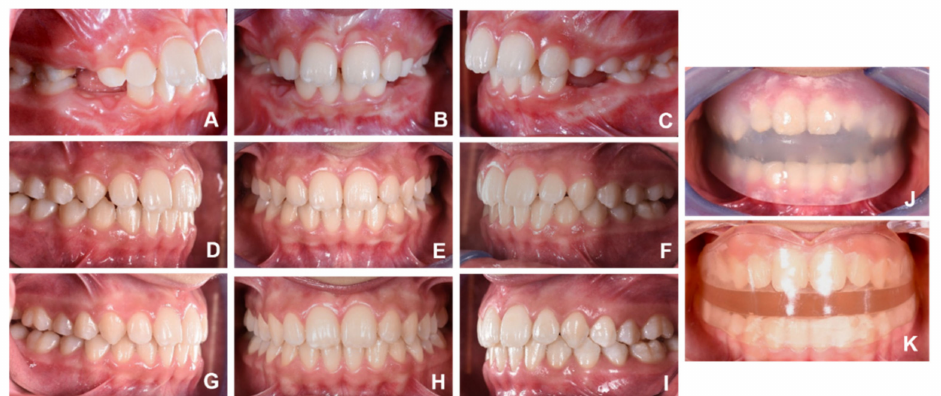
Figure 6. ( A – K )—A 10-year-old female patient (D.L.) with atypical swallowing, a contraction of the upper arch, an augmented overjet, proinclination of the upper incisors and a class II malocclusion. A cephalometric analysis revealed a skeletal class II (ANB 9.3 ◦ ) and mild hyperdivergency (S-NˆGo-Gn 35.5 ◦ ). The first phase of treatment with AMCOP ® Integral for 8 months allowed to expand the upper arch, reduce the hyperdivergency, improve the dentoskeletal class and correct the overjet. Subsequently, AMCOP ® SC induced the complete correction of the sagittal problem. Intraoral photos of the patient: pre-treatment ( A – C ); the intermediate phase ( D – F ); and post-treatment ( G – I ). Patient wearing AMCOP ® Integral ( J ) and AMCOP ® SC ( K